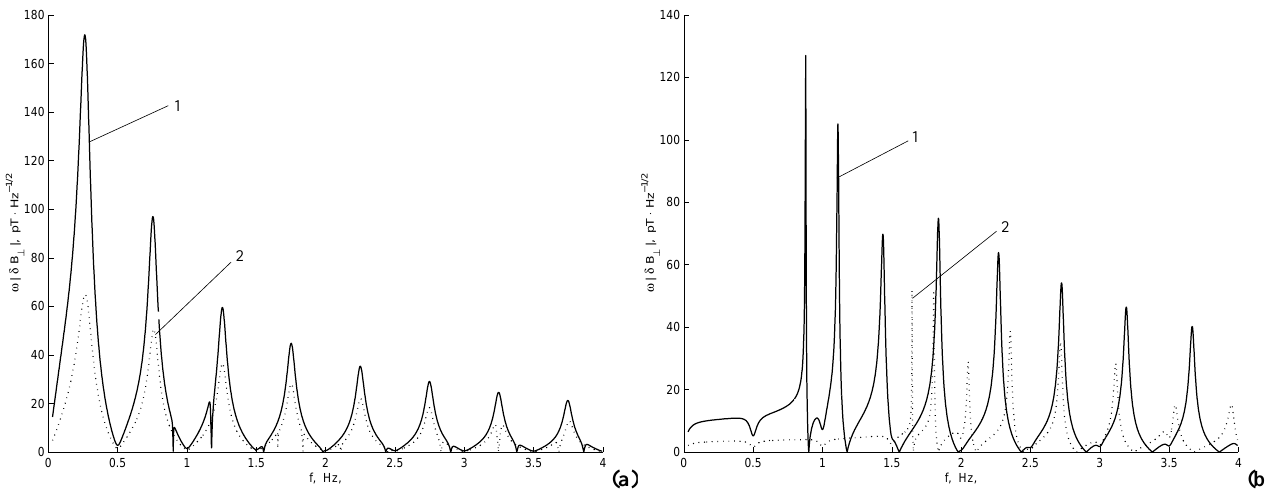
Fig. 4. A normalized power spectrum of the horizontal magnetic field at the ground level. (a) – daytime conditions, (b) – nighttime conditions. The solid line (1) and the dotted line (2) correspond to k 0 = 0 . 01 and 0 . 02km − 1 ,